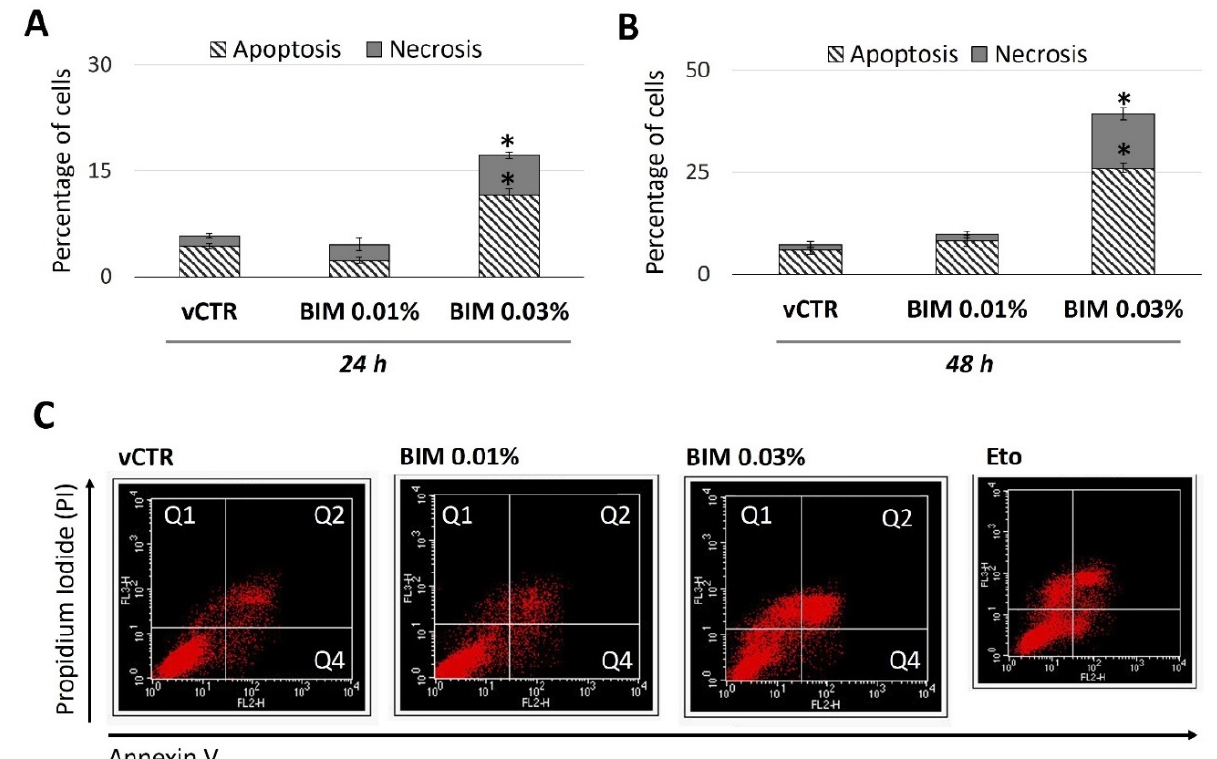
Figure 5. Increased levels of apoptosis and necrosis in BIM 0.03%-exposed cells. Cell death analyses (percentage of cells) in HCE cells incubated in the absence (vCTR) or the presence of BIM 0.01% and 0.03% for 24 ( A ) and 48 h ( B ); BIM 0.03% induces significant changes in the percentage of cells undergoing apoptosis and necrosis, at 24 and 48 h; no relevant effects for BIM 0.01% are detected. ( C ) Representative FACS images of AnnexinV/PI analyses, at 48 h treatment (Q1 = necrosis; Q2 = late apoptosis; Q4 = early apoptosis); cells treated with 25 µM Etoposide (Eto) for 24 h were used as a positive control for apoptosis induction. Values from three independent experiments are expressed as the media ± SE; one-way ANOVA (Dunnett’s method); * p < 0.05 compared with vCTR.